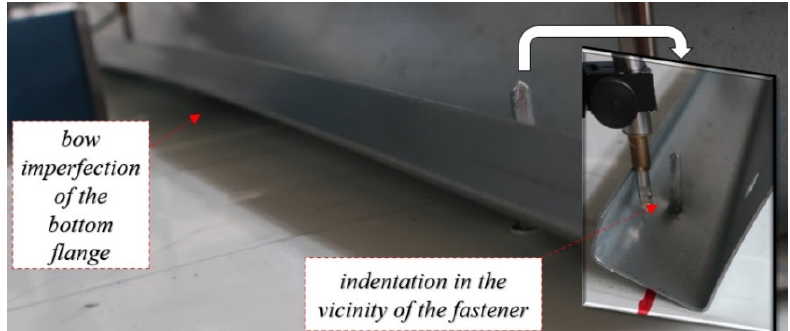
Figure 9. Failures in the nonlinear stage of the kinematical response of the connection (stage II) using self ‐ drilling fasteners (F).